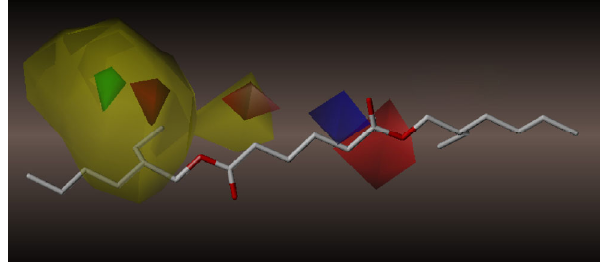
Fig. 40 CoMSIA contour diagram for wear with embedded bis(2- ethylhexyl) adipate as reference for both steric and electrostatic fields. Green and yellow regions show where steric bulk is favored and disfavored, respectively. Blue region shows where positive charge is favored while red region shows where negative charge is favored.